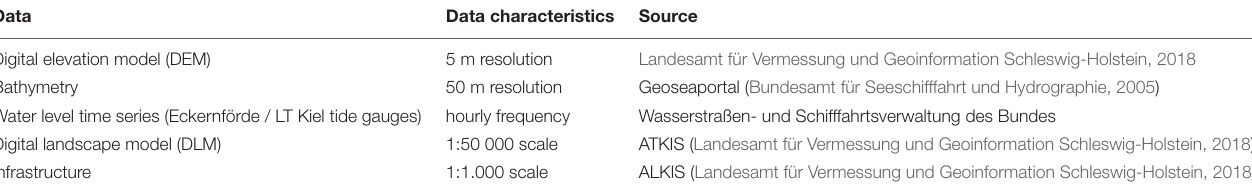
TABLE 1 | Summary of